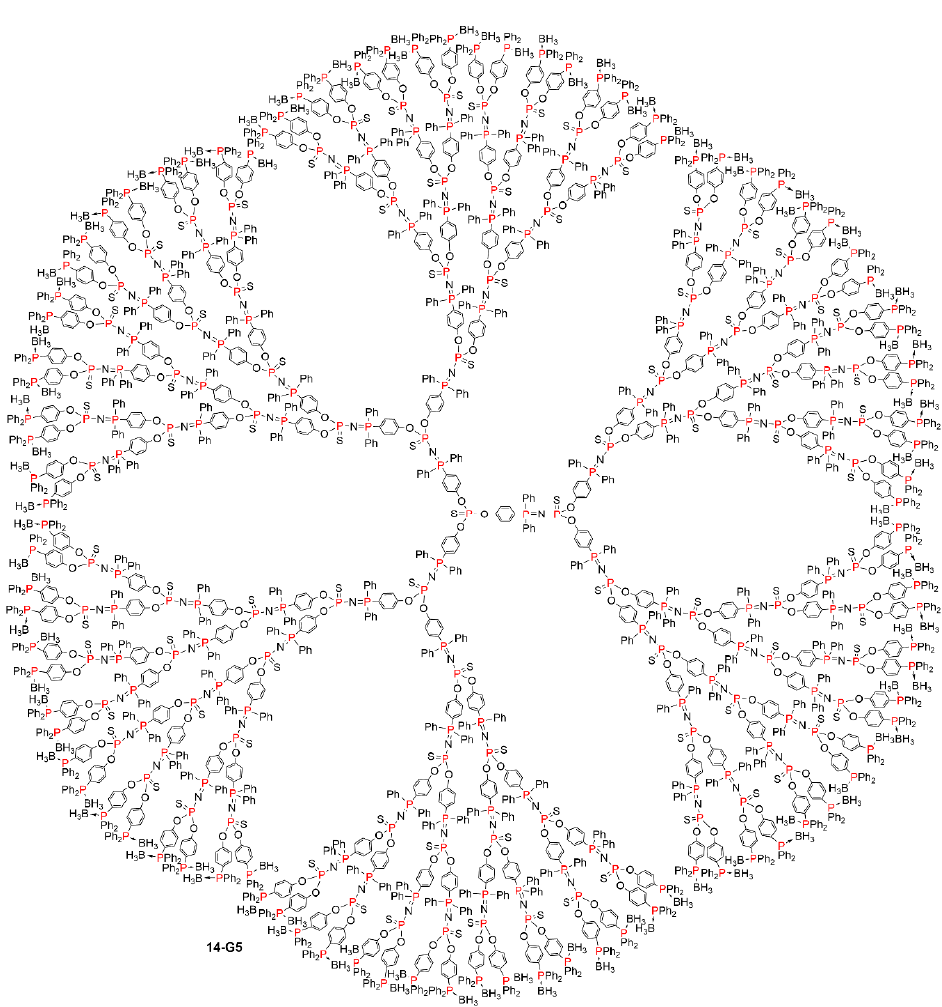
Figure 8. Full chemical structure of the dendrimer 14-G5 shown in a linear form in Scheme 14. Exactly the same process was applied later to triphenylphosphine used as core. The synthesis was carried out up the third generation, functionalized by diphosphines on the surface, as shown in Figure 9 [34].